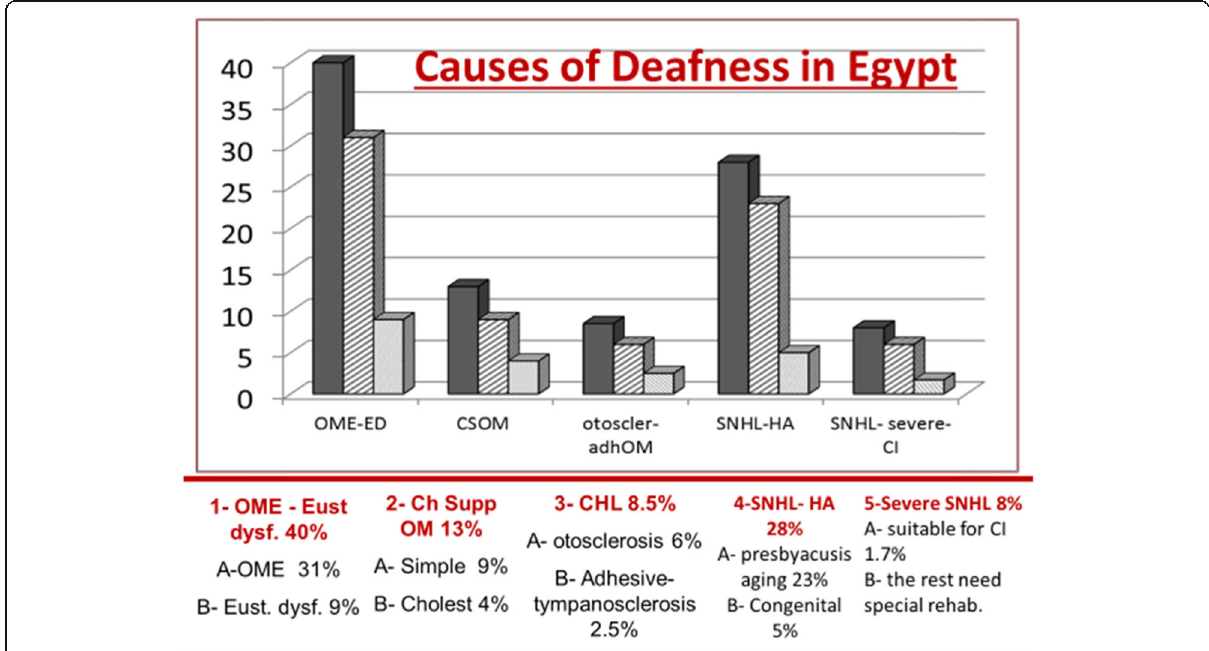
Fig. 1 Causes of deafness in Egypt. Hatched column refers to the more frequent cause, the light one refers to the less frequent one as cited below the columns, and the black column refers to the sum of